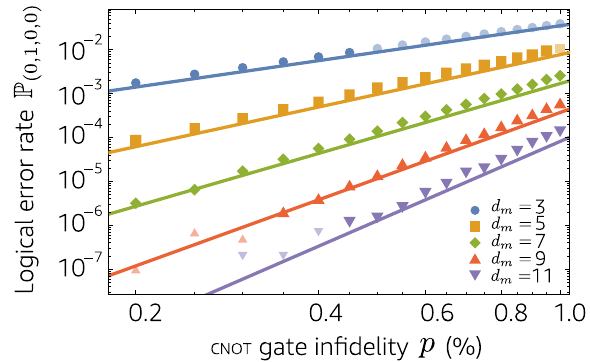
FIG. 9. A comparison between the best-fit polynomial P ( 0,1,0,0 ) for various values of d m given in Eq. (3) with the data obtained from our Monte Carlo simulations. We choose parameters where d x = 9, d z = 11, r = d z , and (cid:6) = 5. The translucent data points are omitted when obtaining the fitting polynomial in Eq.